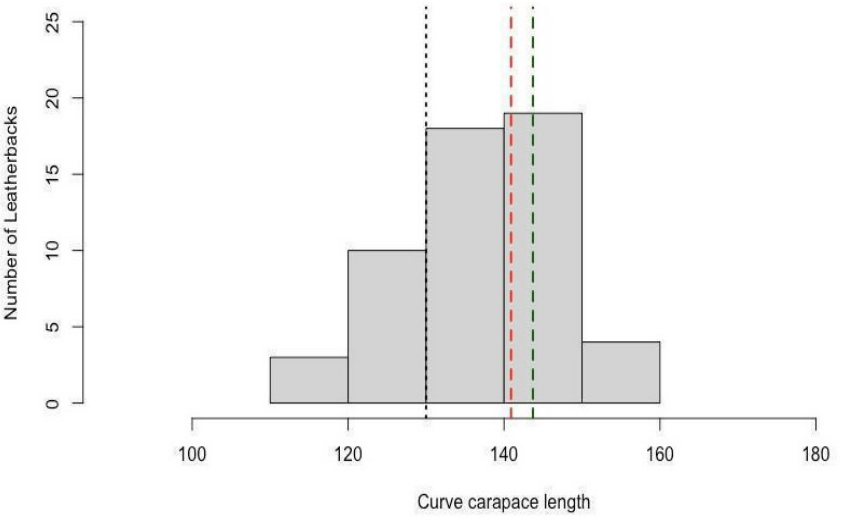
Figure 3. Curved carapace length (CCL) of leatherback turtles recorded in Uruguay (n = 98). Black dashed line indicates the minimum CCL of nesting females at 130 cm from the nearest nesting colony in Brazil (adapted from Thomé et al. [15]). Red dashed line indicates the mean size of females (n = 43) and the green dashed line the mean size of males (n = 21).